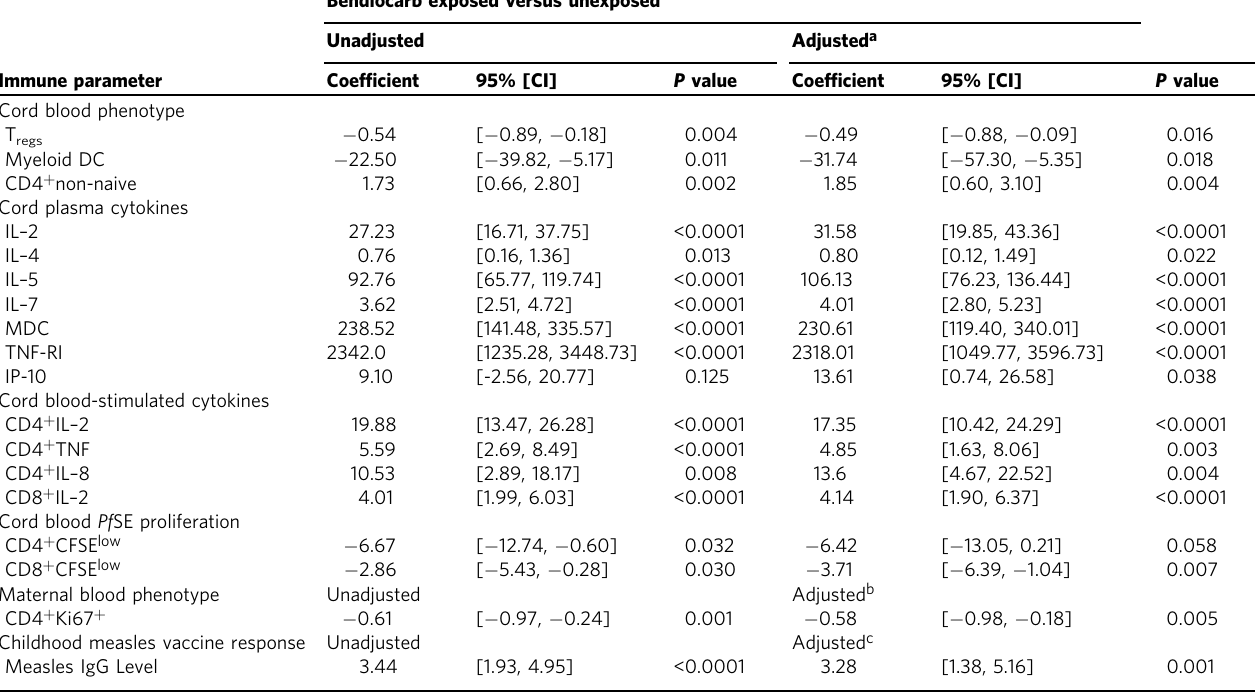
Table 2 Multivariate analysis of immune parameter by prenatal bendiocarb